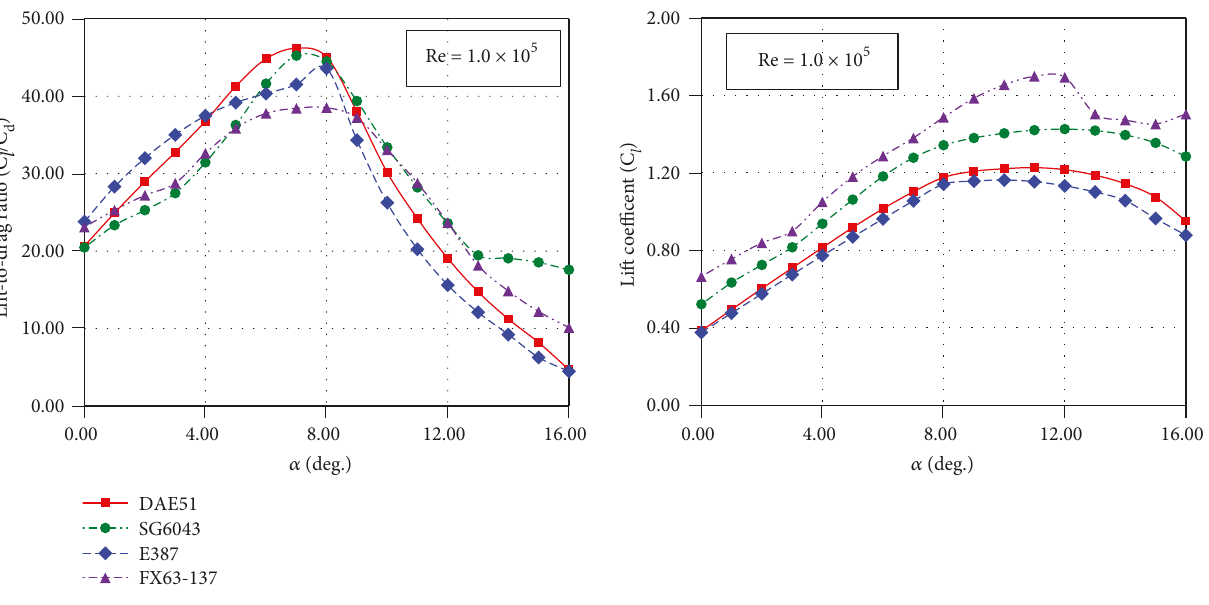
Figure 4: Example of CFD results for several airfoils at Re = 10 5 .